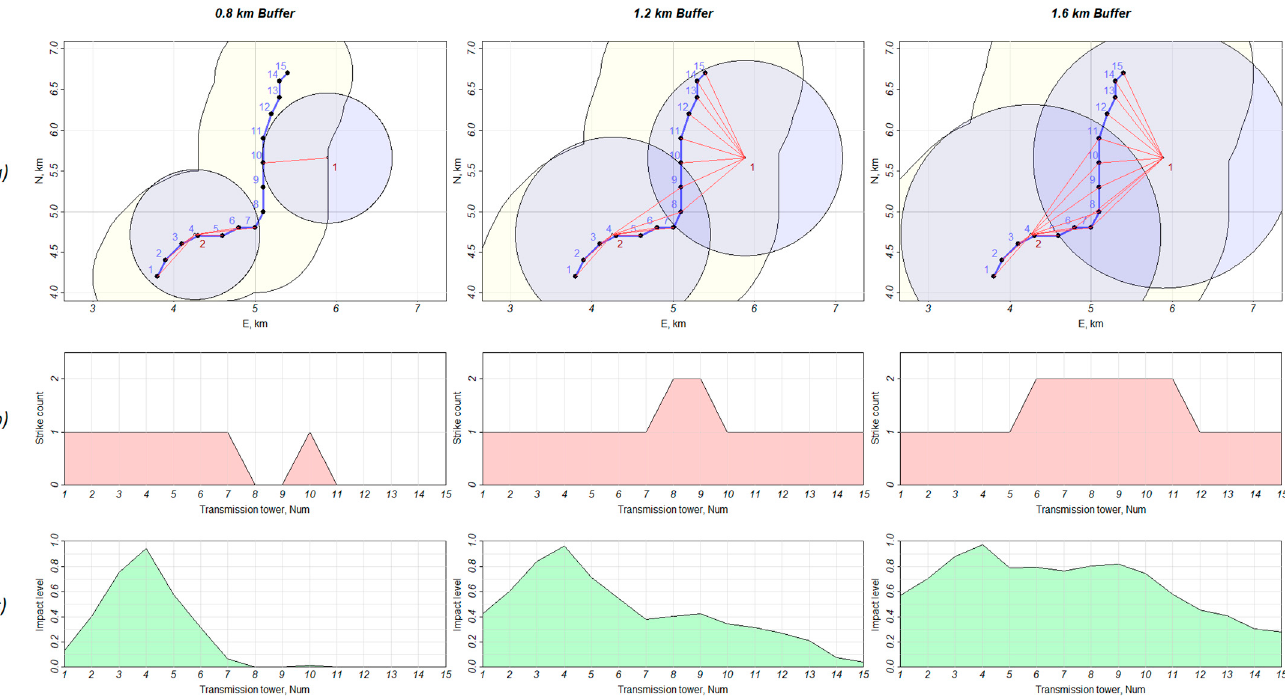
Figure 1. The ( a ) row shows the location of power lines and lightning strikes on the ground. The plots in the ( b ) row show the total number of lightning strikes that affect each tower. The plots in the ( c ) row show the desired impact level on the power lines according to the proposed method.